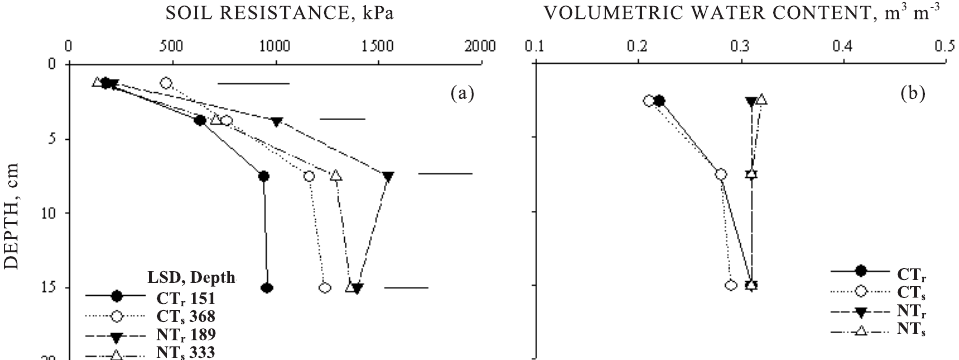
Figure 3. Soil penetration resistance (a) and volumetric water content at the time of soil penetration resistances evaluation (b) under conventional tillage (CT) and no-tillage (NT) and rotation (r) and succession (s) crop cultivation systems in Humic Cambisol, Lages, 2008. Horizontal bars indicate least significant differences between treatments at the same depth, based on the t test. Means of four replications. n = 64. CV soil resistance = 20